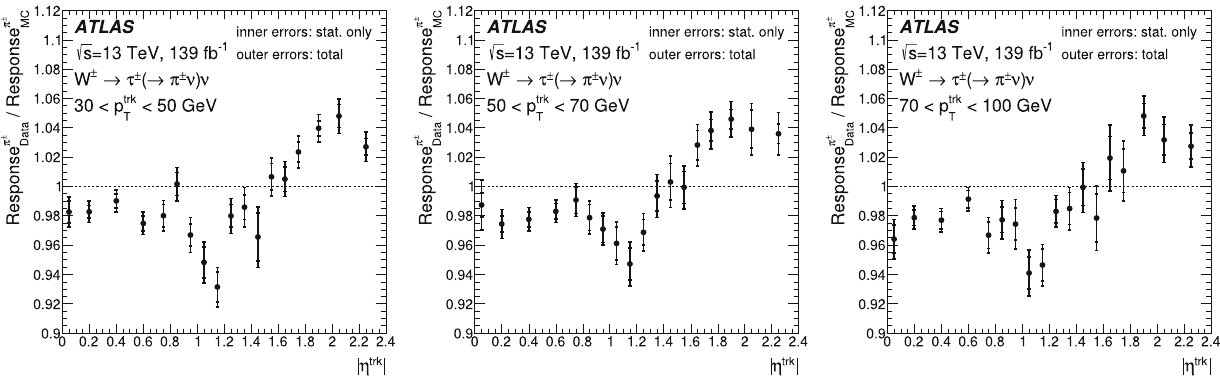
Fig. 7 The measured data to simulation ratio of the response as a sent uncertainties from limited sample size and the outer error bars give < 50 GeV, function of | η trk | for the three p trk ranges: 30 < p trk the total uncertainty including both the statistical errors and systematic T T < 70 GeV and 70 < p trk < 100 GeV. Inner error bars repre- 50 < p trk T T